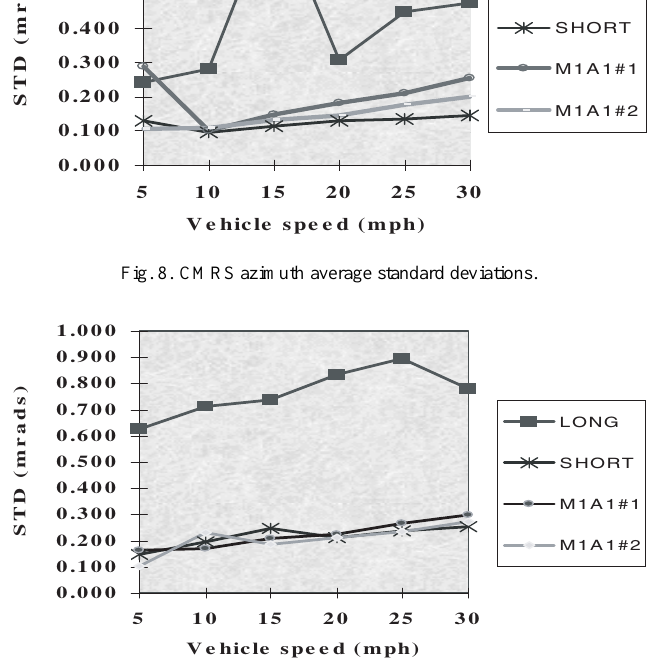
Fig. 9. CMRS elevation, average standard